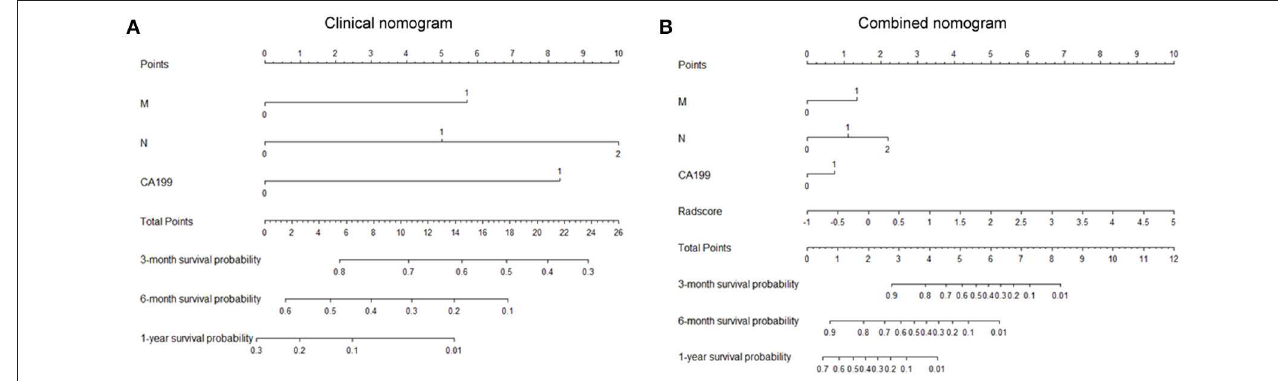
FIGURE 2 | Nomograms for the clinical and combined models. (A) Clinical nomogram based on three clinical predictors. (B) Combined nomogram based on three clinical predictors and the radiomics signature. To use these nomograms, the user locates an individual patient’s value on each variable axis and draws a line up to determine the number of points received for each variable value. The sum of these numbers is located on the axis of total points, and three lines are drawn down to the risk axes to determine the 3-, 6-, and 12-month RFS probabilities.